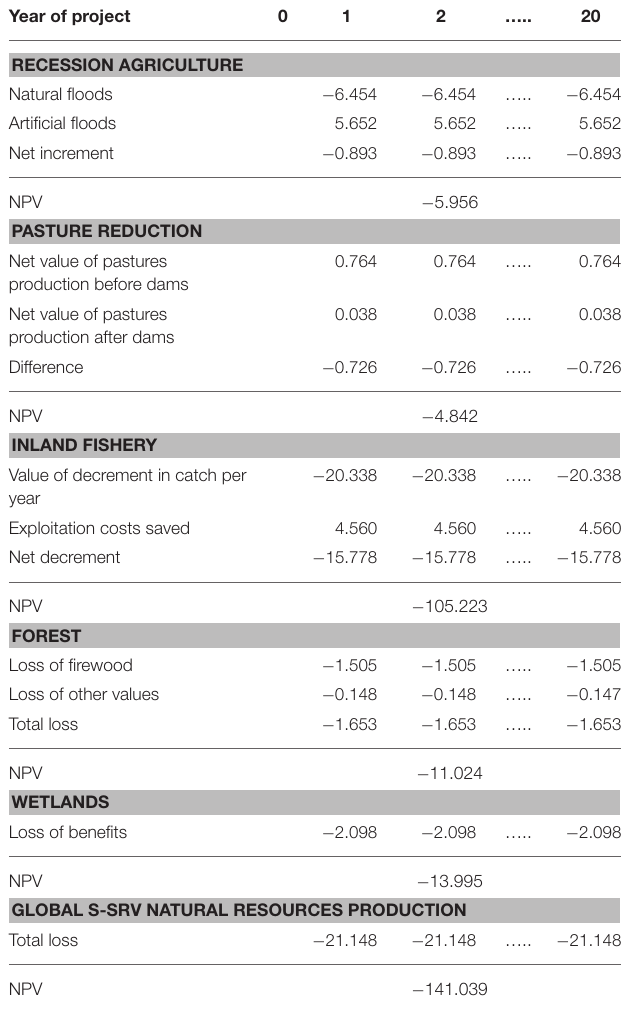
TABLE 5 | Sensitivity analysis, switching values, and percent of change of the tested parameters needed to attain 12 and 0% of the ERR (scenario I). Parameter Base ERR (%) Switching